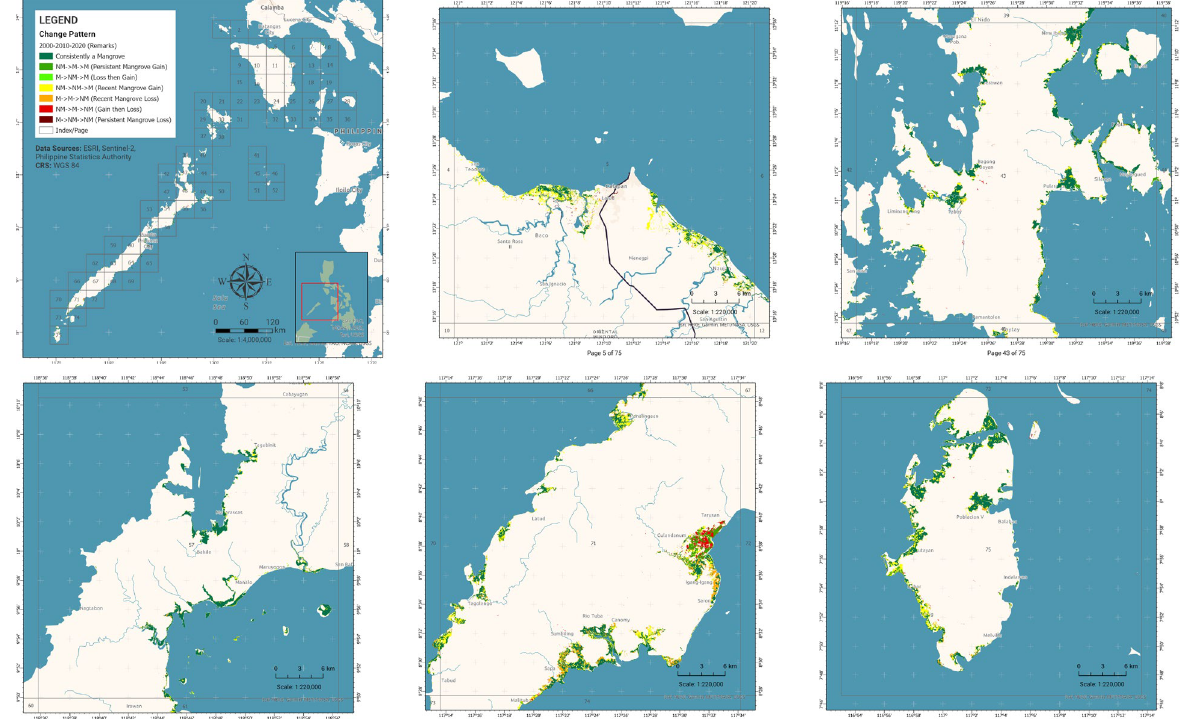
Figure 3 . Region IV-B Decadal Mangrove Cover Change Pattern Map Series and select indices/pages with notable change